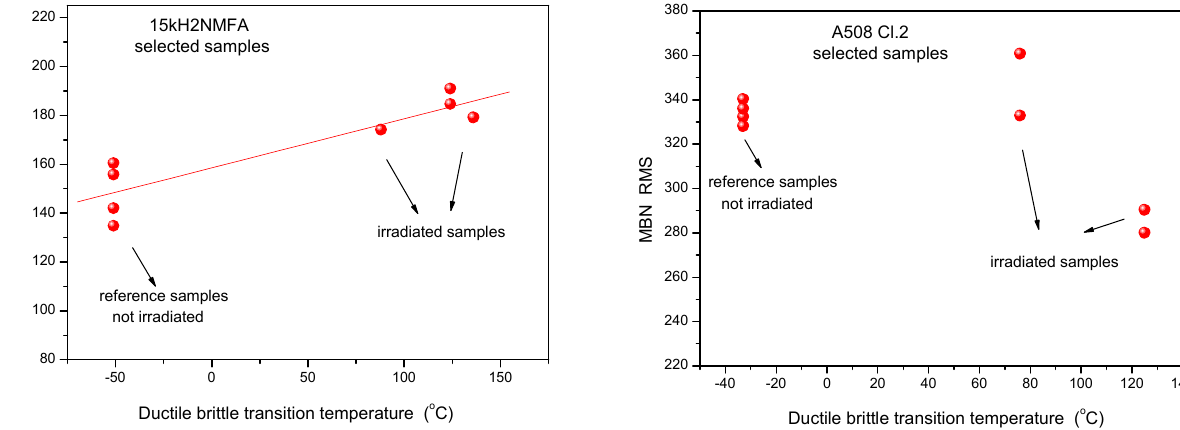
Figure 12. 3MA P3 parameter vs. transition temperature for selected 15kH2NMFA and A508 Cl.2 samples.